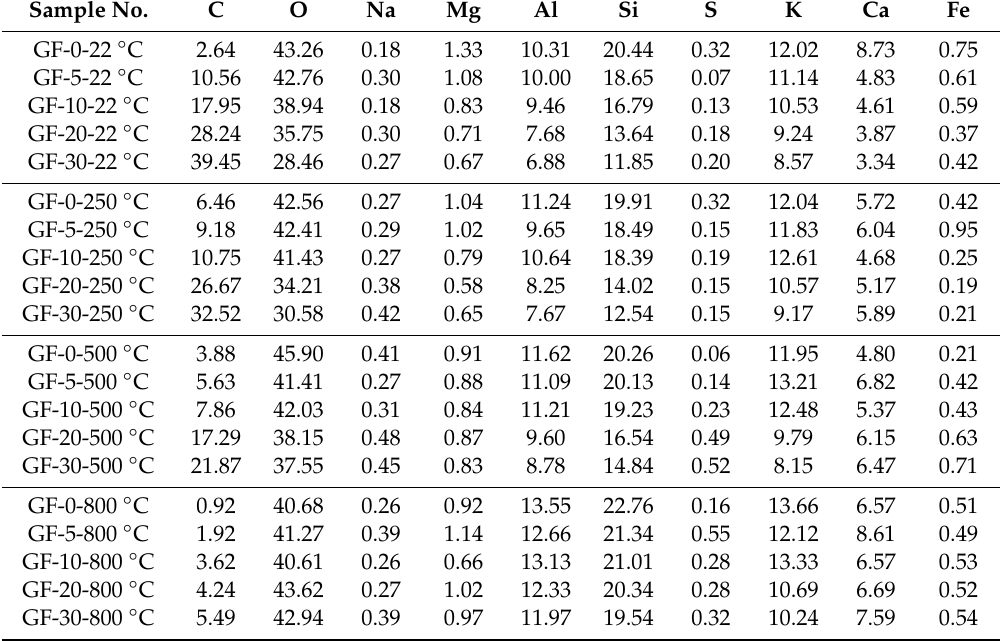
Table 4. Elemental analysis of the geopolymer foam composites at elevated temperatures (wt %). Sample